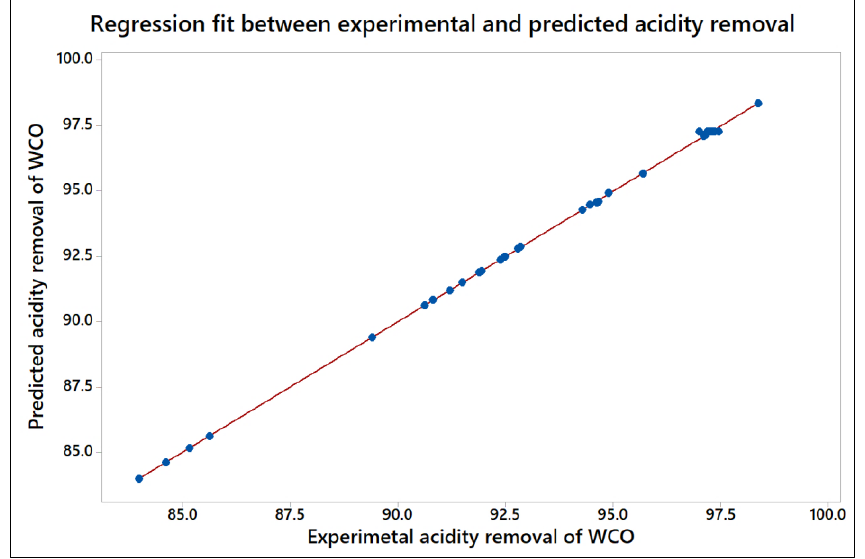
Table 9. Optimal response analysis for the esterification of WCO using the RSM analysis method.